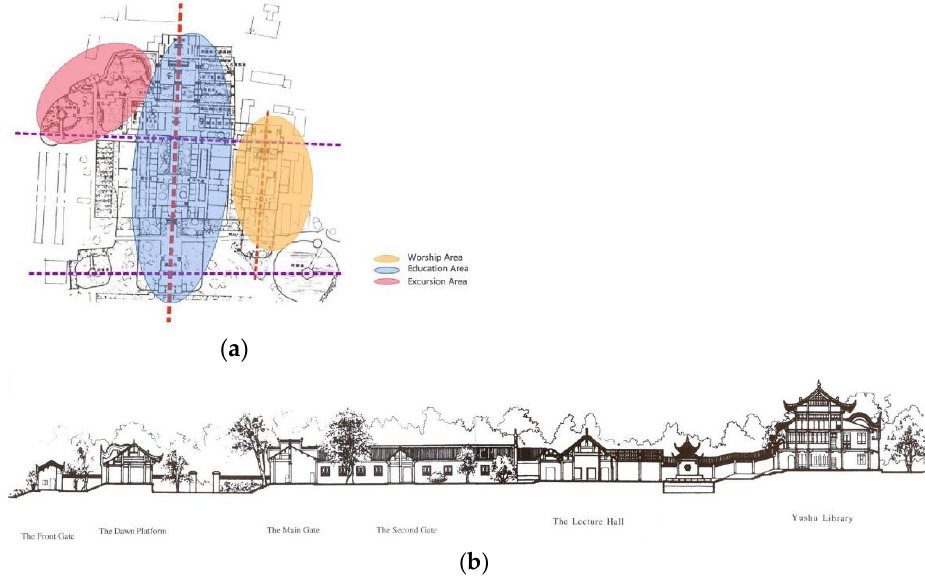
Figure 8. ( a )Axis and Functional Zoning Diagrams of the Yuelu Academy (author’s drawing); ( b ) cross-section of the Middle Axis of Yuelu Academy (source: Architecture and Culture of Yuelu Academy, Yang Shen-chou).